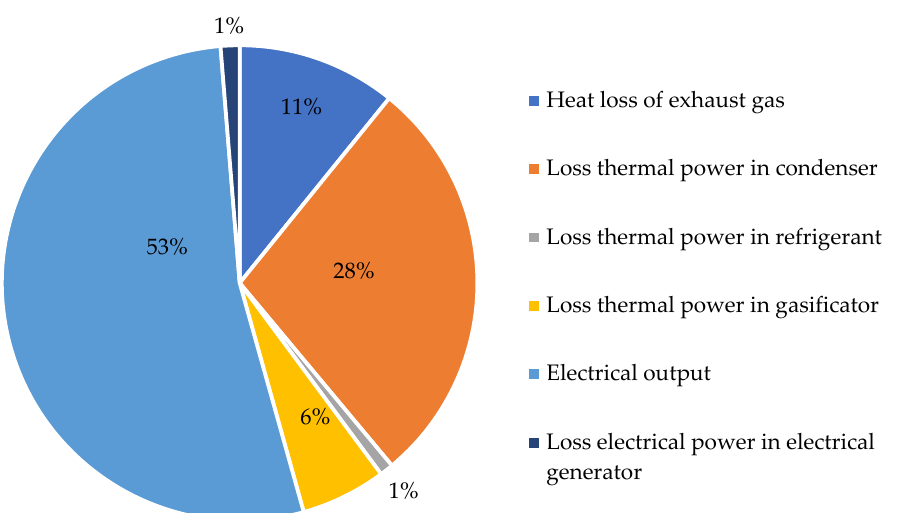
Figure 8. Power structure of the cycle with gasification steam bleeding from the turbine.